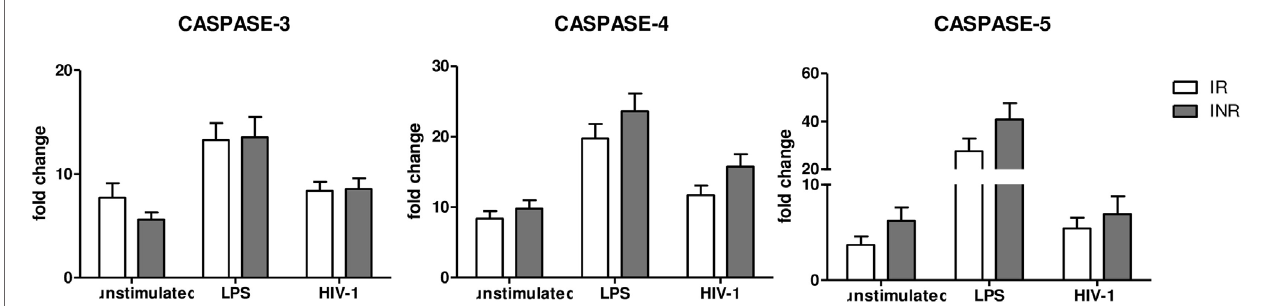
FigUre 3 | Caspase 3, 4, and 5 gene expression. Caspase 3, 4 and 5 expressions were quantified in peripheral blood mononuclear cells (PBMCs) from each patient enrolled in the study ( n = 22 for immunological responders (IRs) and n = 17 for INRs) either unstimulated or LPS or AT2-treated-HIV-1 BaL stimulated. Mean values and SEM are shown. White bars represent IRs, gray bars represent INRs. Fold change expressed as 2 Δ Δ Ct